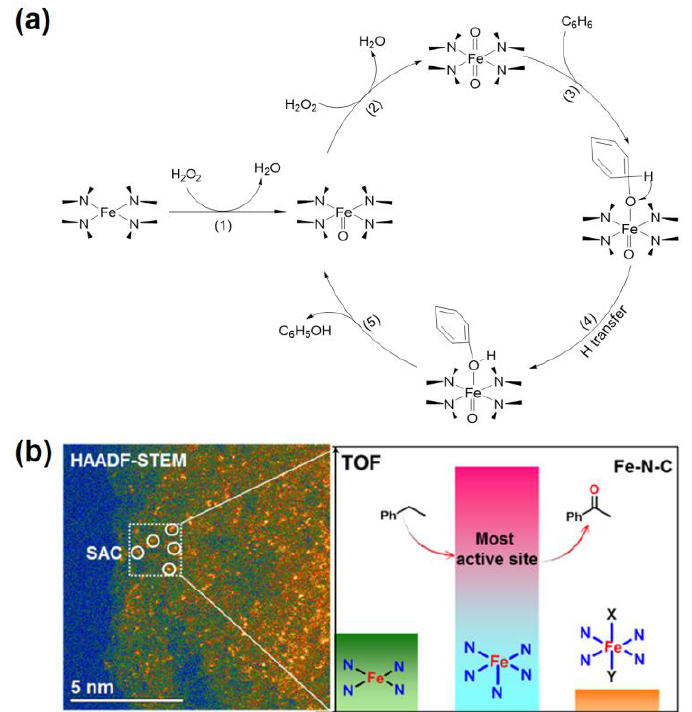
Figure 9. ( a ) The proposed catalytic mechanism for FeN 4 /GN catalyzed transformation of benzene to phenol. ( b ) HAADF-STEM image of Fe-N-C and a turnover frequency (TOF) comparison of different iron sites on the Fe-N-C towards the oxidation of C-H bond. Reprinted with permission from Ref. [60]. Copyright 2017, American Chemical Society.